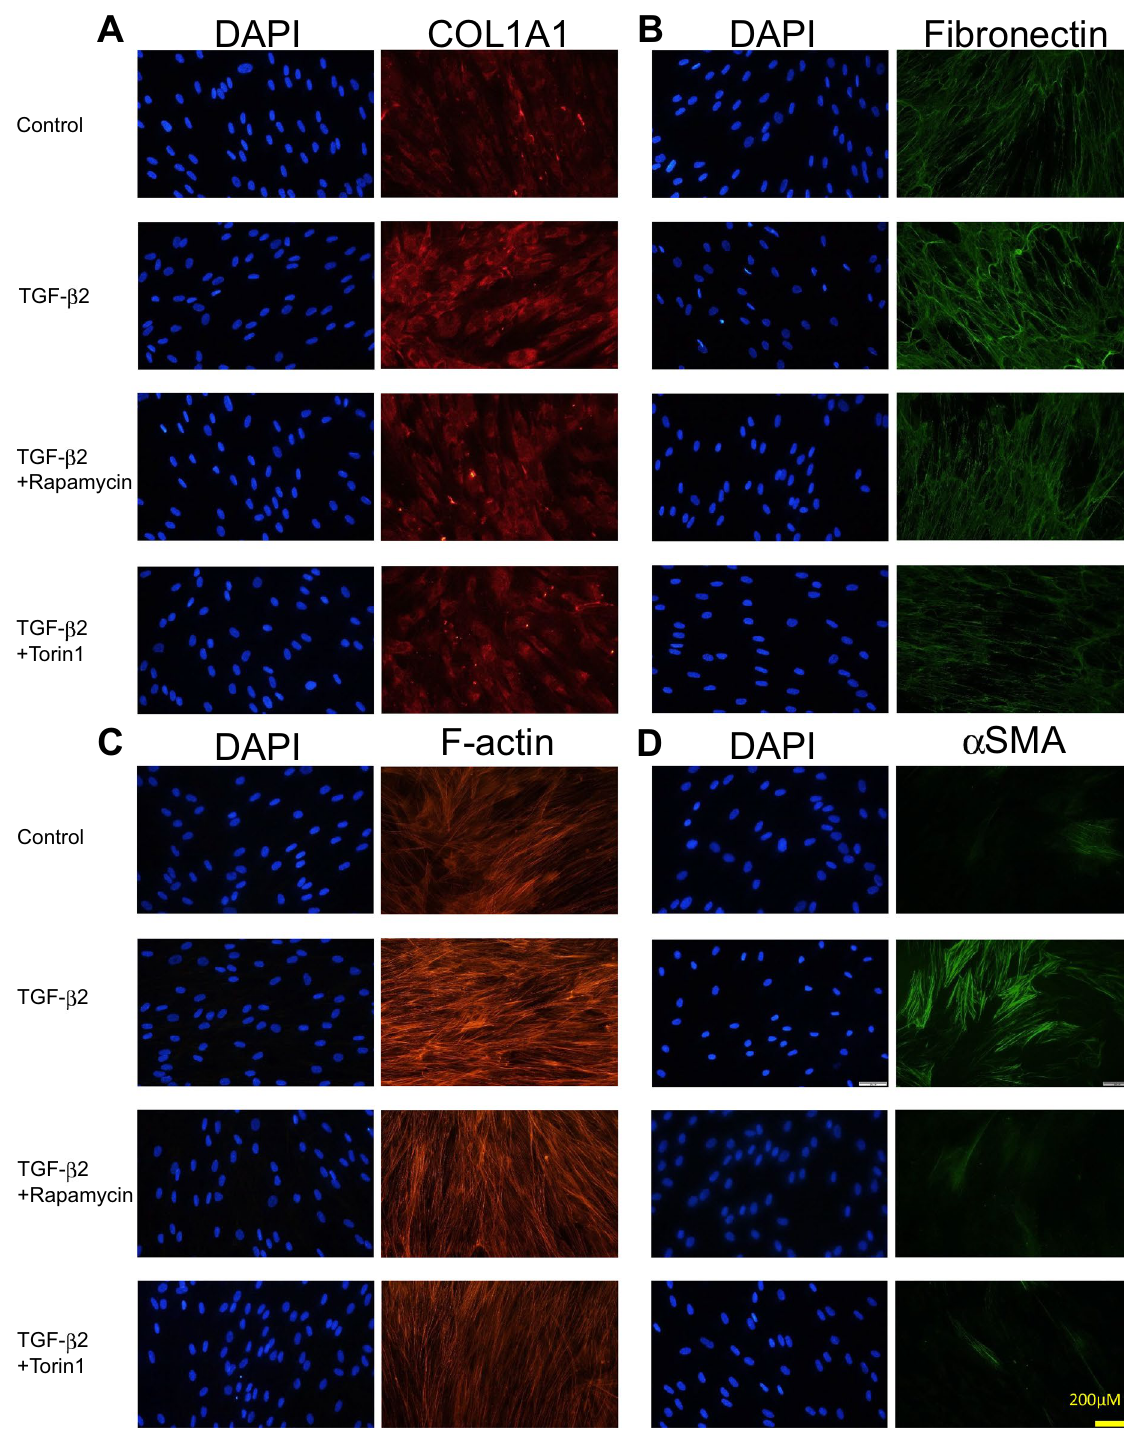
Figure 2. Immunocytochemistry detecting COL1A1, fibronectin, F-actin, and αSMA in hTM cells. The first panel shows cells that were not treated with TGF-β2 or mTOR inhibitors. The second panel shows cells treated with TGF-β2. The third panel show cells treated with TGF-β2 and 100 nM rapamycin. The fourth panel shows cells treated with TGF-β2 and 100 nM Torin 1. Cells stained with DAPI are shown by the left rows, and the staining levels of COL1A1 ( A ), fibronectin ( B ), F-actin ( C ), and aSMA ( D ) are shown by the right rows. These materials were upregulated in hTM cells exposed to TGF-β2, and the fibrotic responses were significantly suppressed by the mTOR inhibitors rapamycin and Torin